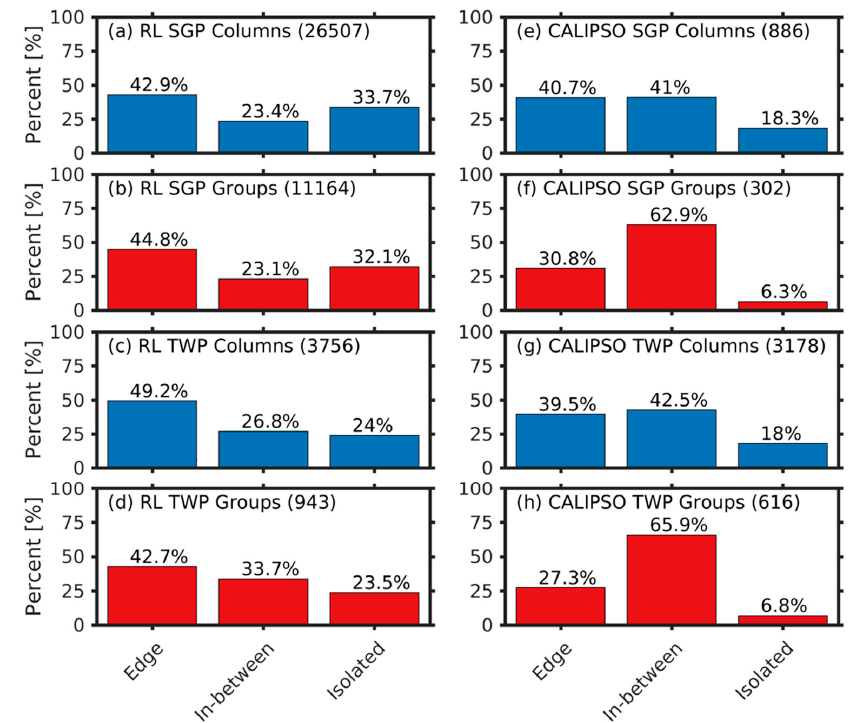
Figure 4. Percentage breakdown of the transparent ice cloud profiles with ice cloud column optical depths below 0.01 into “edge”, “in-between” and “isolated” for the RL (left) and CALIPSO (right) at the SGP (top two) and TWP (bottom two) sites. “Edge” refers to one of the adjacent profiles with an ice cloud column optical depth above 0.01 and where the other adjacent profile is clear sky. “In-between” refers to both of the adjacent profiles with an ice cloud column optical depth above 0.01. “Isolated” refers to both of the adjacent profiles being clear sky. The percentage breakdown is considered for columns (blue) and groups (red), where columns count all transparent ice cloud profiles with ice cloud column optical depths below 0.01 equally and groups count consecutive transparent ice cloud profiles with ice cloud column optical depths below 0.01 as one group. The total number of samples for each panel is given in the parentheses. Data for the RL at the SGP site are from August 2008 to August 2016 and at the TWP site from December 2010 to January 2015. Data for CALIPSO for both the SGP and TWP site are from June 2006 to August 2016.